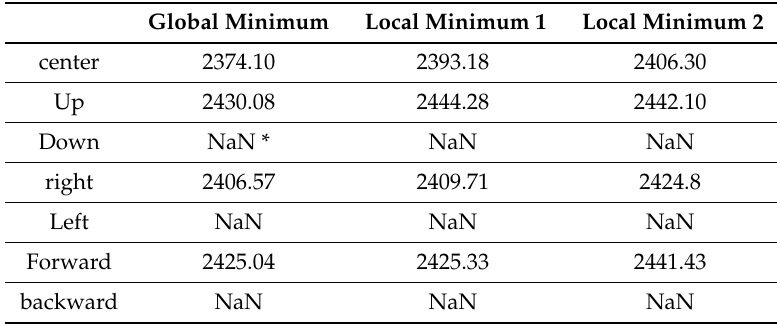
Table 5. Points near the local and global optimal points.